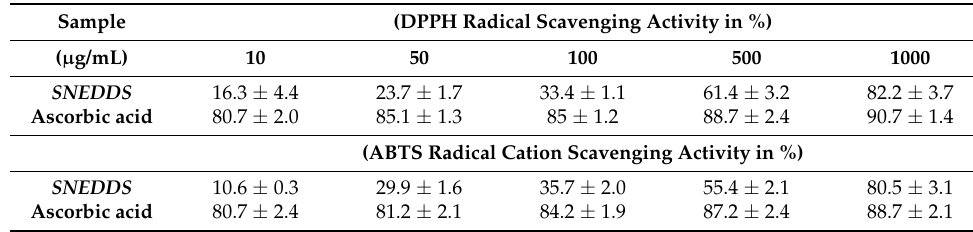
Figure 3. TEM images showing the structure and shape of the droplet sizes of the SNEDDSs at ( A ) 80,000× and ( B ) 250,000× magnifications. Table 3. Scavenging activities of the representative